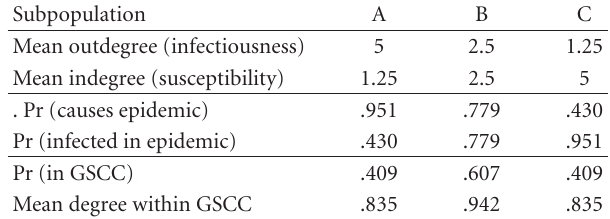
Table 1: Summary of the mass-action model from Section 4.1. Subpopulation A has high infectiousness but low susceptibility, subpopulation B has average infectiousness and susceptibility (by both arithmetic and geometric mean), and subpopulation C has low infectiousness but high susceptibility. Nodes in subpopulation B have the highest probability of being in the GSCC and the highest expected number of edges connecting them to other nodes in the